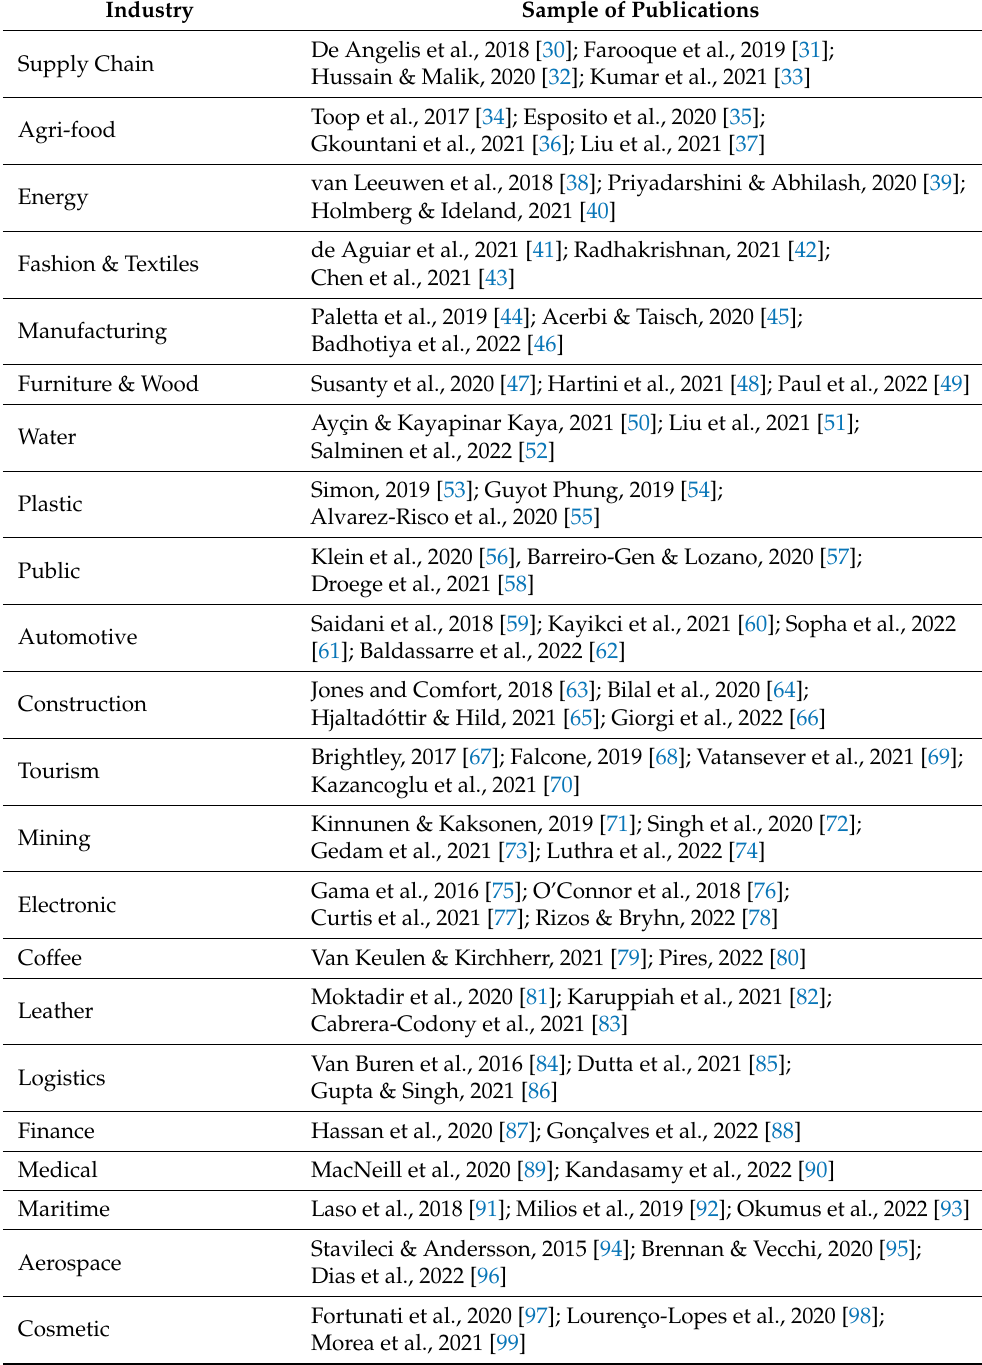
Table 1. Circular economy